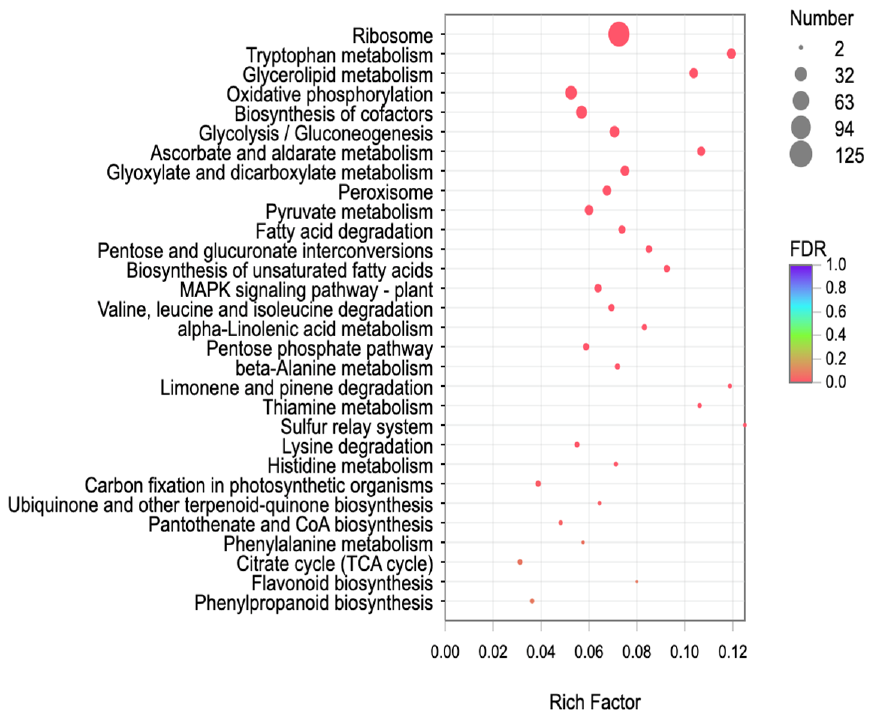
Figure 7. Classification of the top 30 enriched KEGG pathways of the differentially expressed genes between T9 and CK.